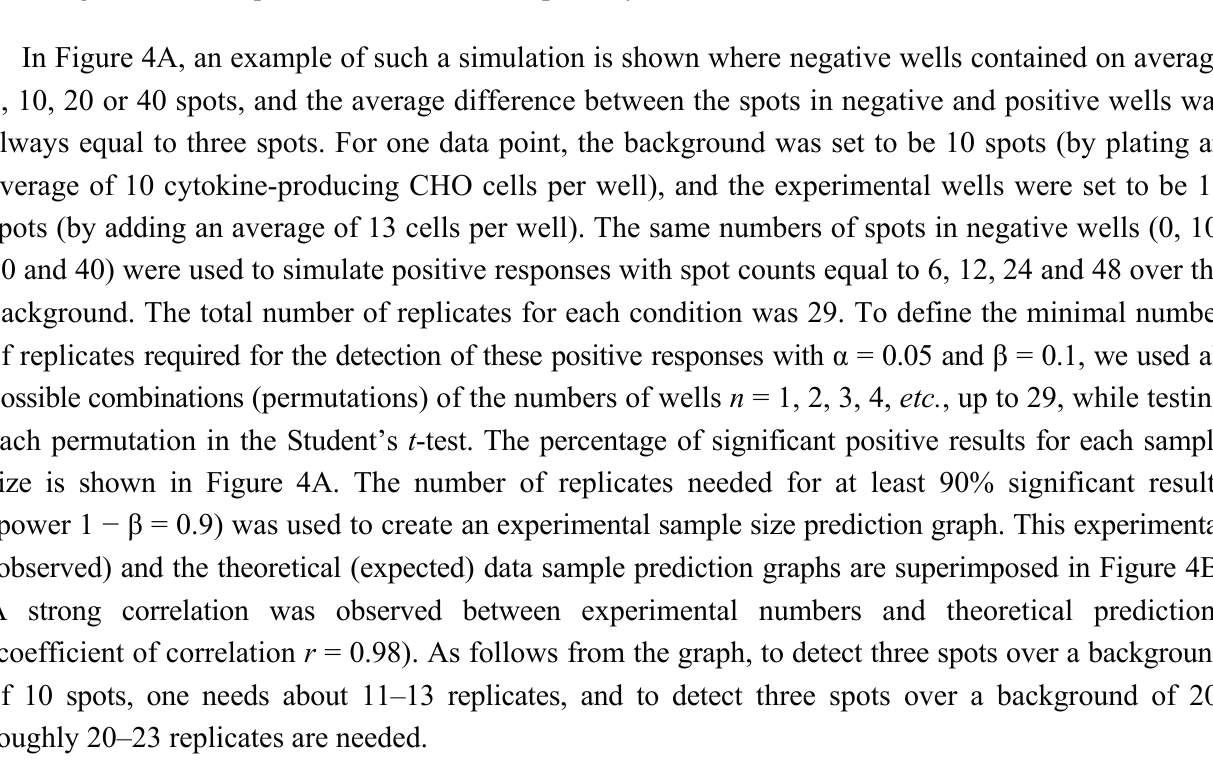
Figure 3. Theoretical prediction for the number of replicate wells required for detecting the difference between two means expressed by “folds” of σ . The numbers of replicates (Y) are calculated in a two-tailed test for a given effect value = δ / σ (X) for two levels of significance α equal to 0.05 and 0.1 and power β set to